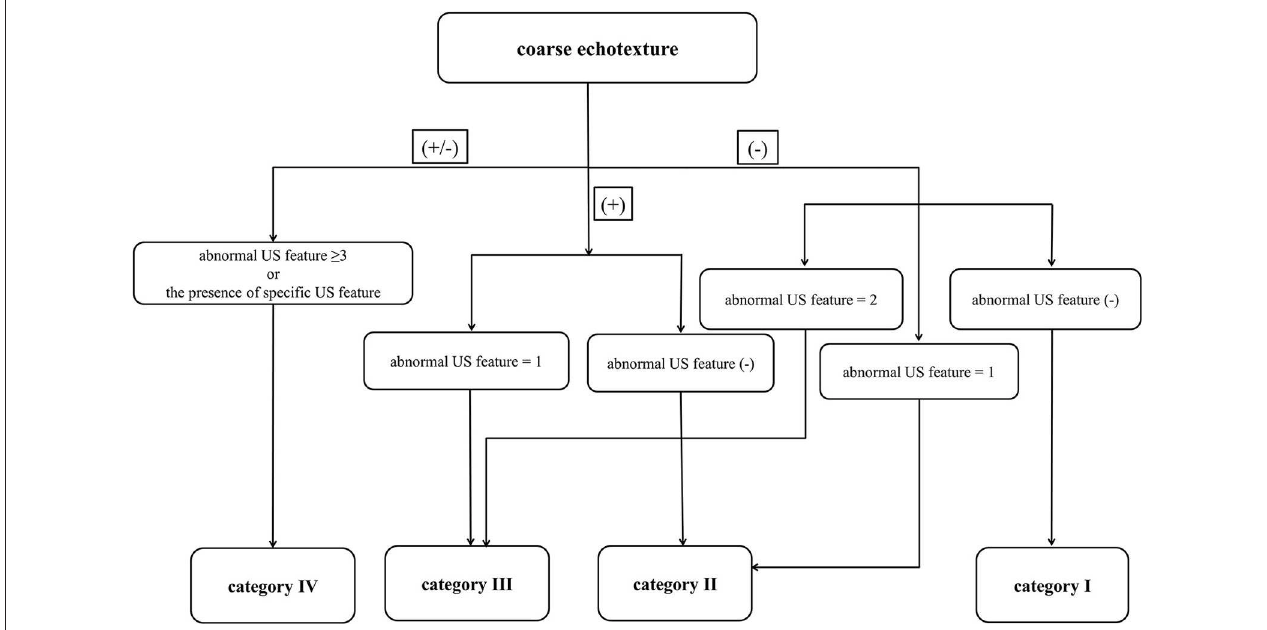
FIGURE 1 | Thyroid imaging reporting and data system (TIRADS) algorithm for diffuse thyroid disease (DTD) with risk stratification based on the number of abnormal ultrasonography (US) features of DTD and the presence of DTD-specific US features. In this algorithm, the specific US features include micronodulation, multifocally ill-defined hypoechoic lesions, and thyroid